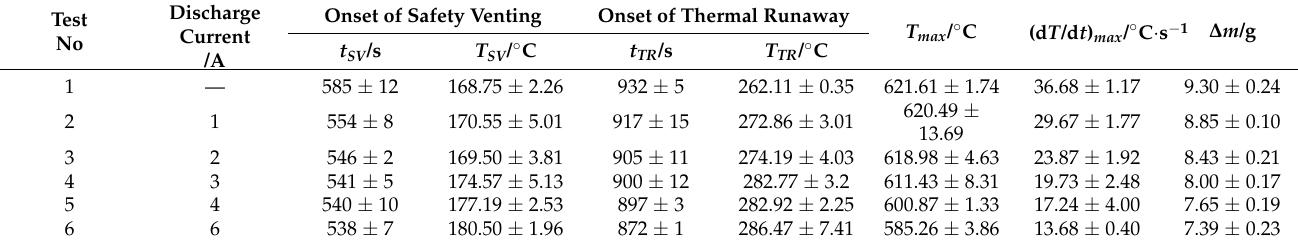
Figure 4. Typical temperature variation of the batteries under different discharge currents in Group ⅱ . Table 4. Key parameters of the thermal runaway at different discharge currents in Group ⅱ .